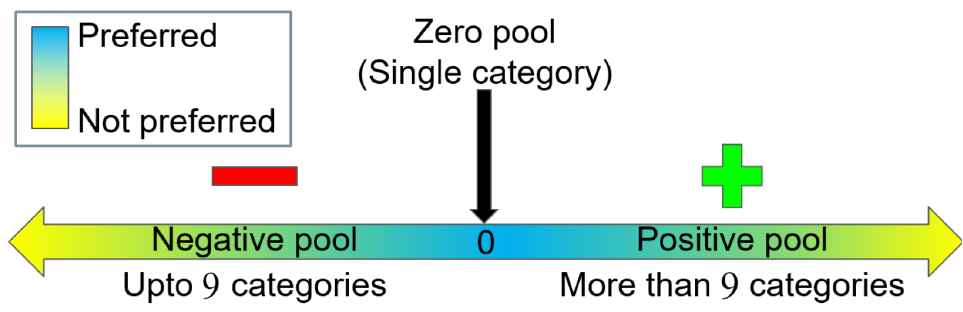
Figure 4. Visualization of the three pools on a irrelevance score for a problem with N o = 20 glo- bal